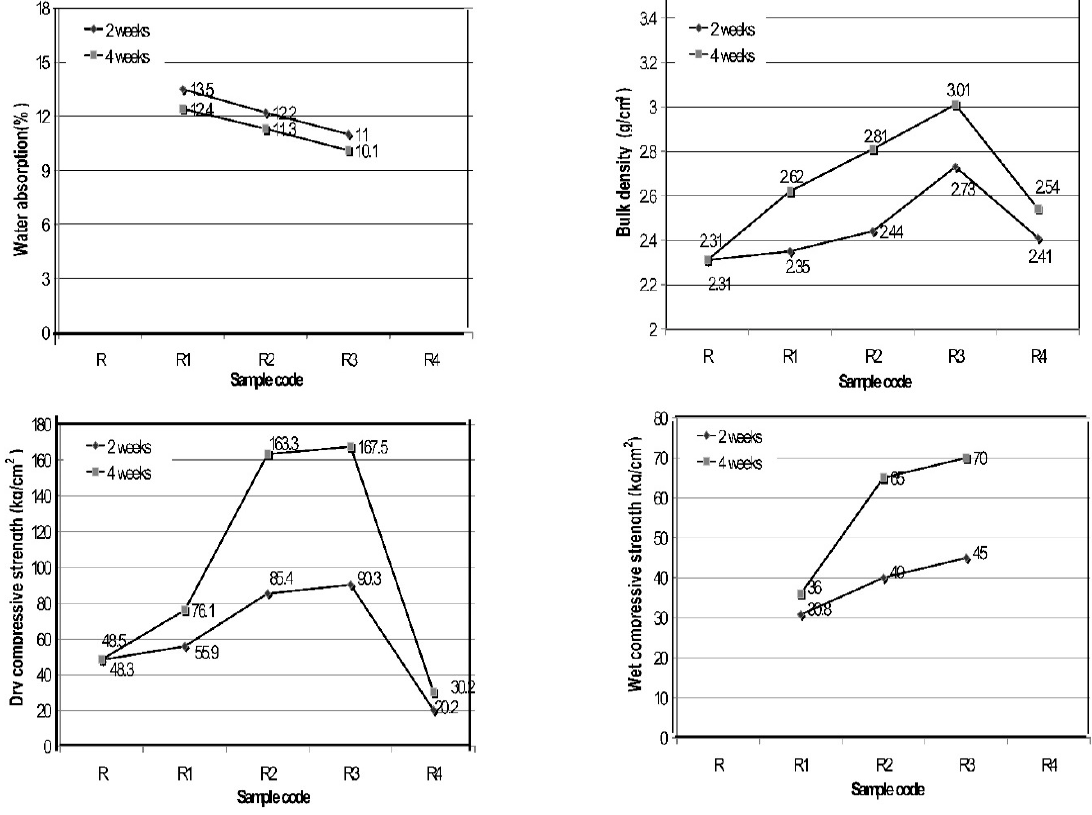
Figure 6 . Water absorption, bulk density, and dry and wet compressive strengths of the specimens of different mixes cured for two and four weeks.